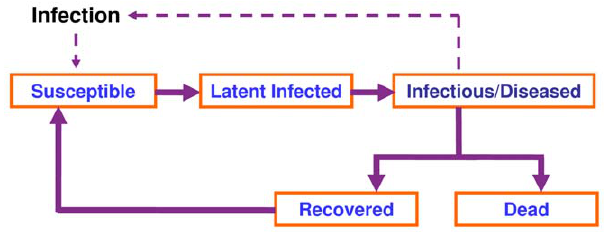
Figure 1. Model for transmission of bacterial or viral infections.